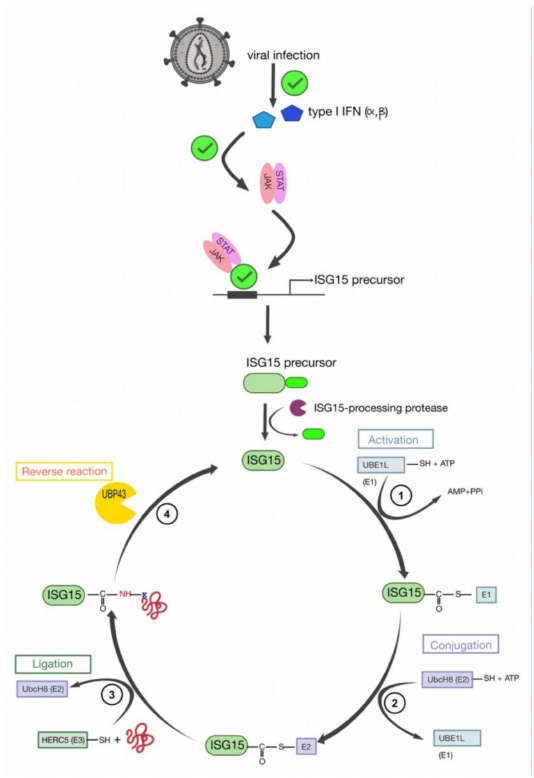
Figure 8. The cycle of ISG15. Viral infection induces the expression of type I IFN. These molecules activate the JAK/STAT signaling pathway, which is responsible for the activation of the ISG15 pro- moter (for reviews see [161,172]). The ISG15 is maturated by ISG15-specific proteases which cleave the C-terminal extension from ISG15 precursor. ( 1 ) The mature ISG15 is activated by UBE1L (E1). It corresponds to the formation of a thioester bond between ISG15 and E1. ( 2 ) ISG15 linked to UBE1L is transferred to UbcH8 (E2). ( 3 ) Finally, E2 recruits an E3 ligase such as HERC5, transferring the activated Ub from the E2 to the K substrate (ligation reaction). ( 4 ) The reaction can be reverted via UBP43. Indeed, it cleaves ISG15 molecules that are conjugated to the substrate proteins via isopeptide bonds (adapted from